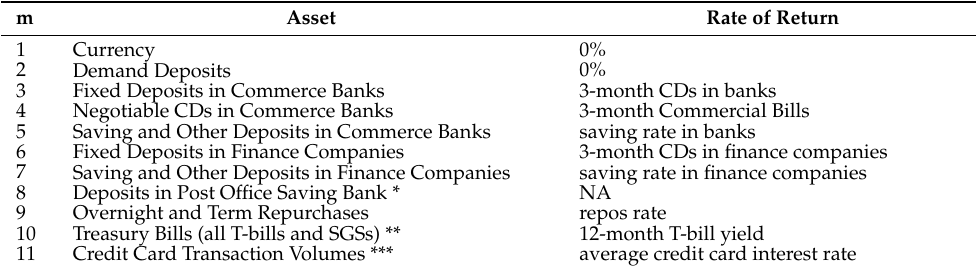
Table 1. Monetary Asset